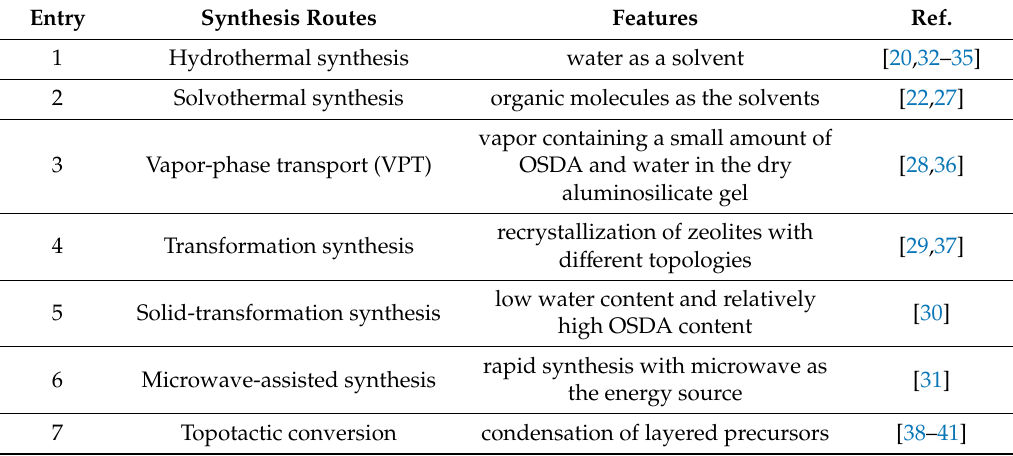
Table 1. Distinguishable features of synthesis routes for the preparation of aluminosilicate ferrierite (FER)